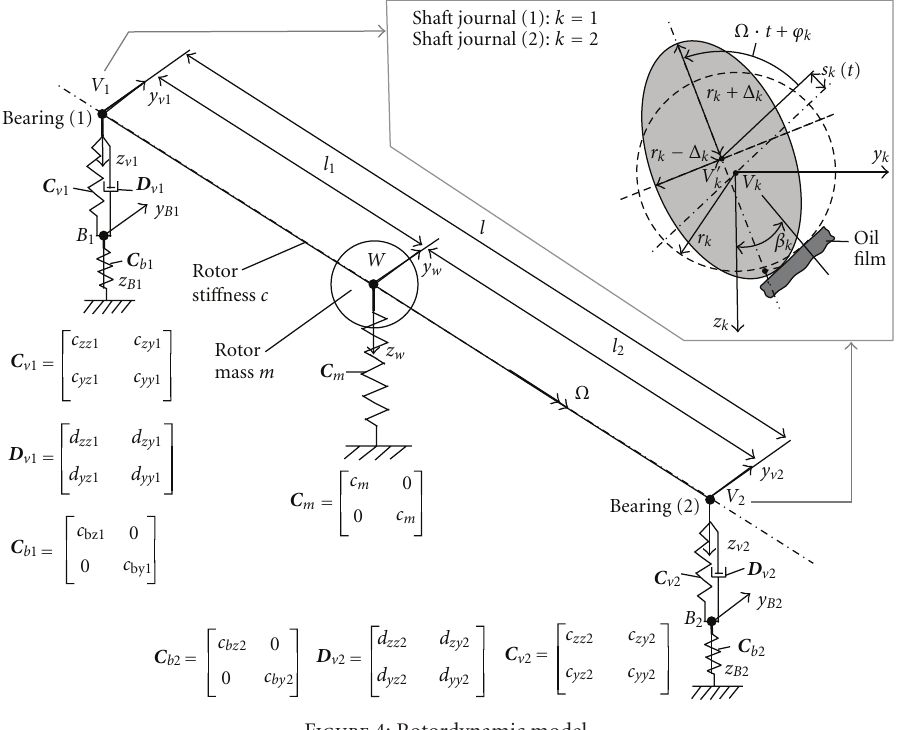
Figure 4: Rotordynamic model.